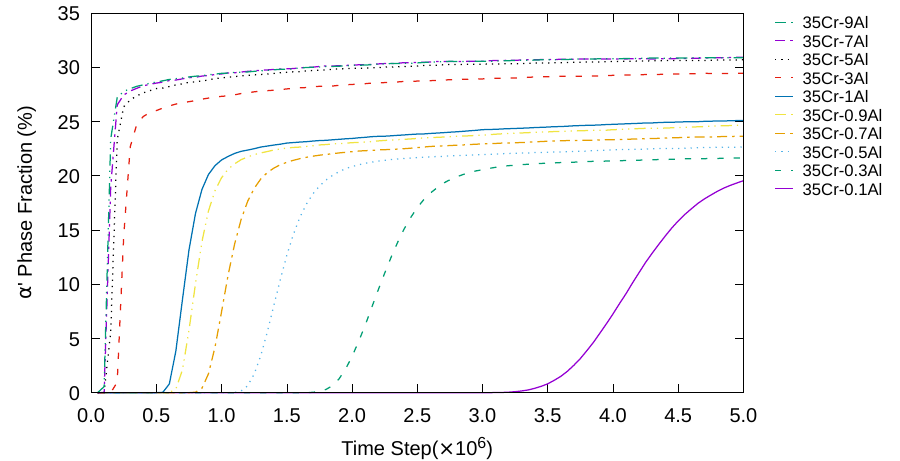
Figure 6. Number of the α (cid:48) precipitates of the 2D simulation when the average Cr concentration was 35% at various average Al concentrations. Overshooting was observed before the t ∗ = 5.0 × 10 5 when the average Al concentration was above 4%.